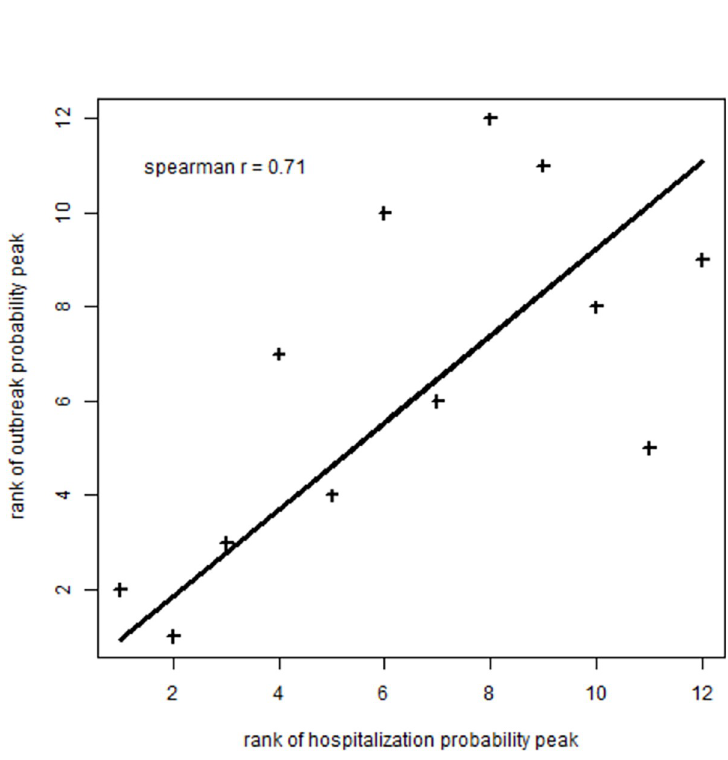
Fig 4. Correlation between Département ranks according to the outbreak probability peak in nursing homes and Département ranks according to the hospitalization probability peak in the population in the Auvergne-Rhoˆne- Alpes Region, France, March 1–July 31, 2020.